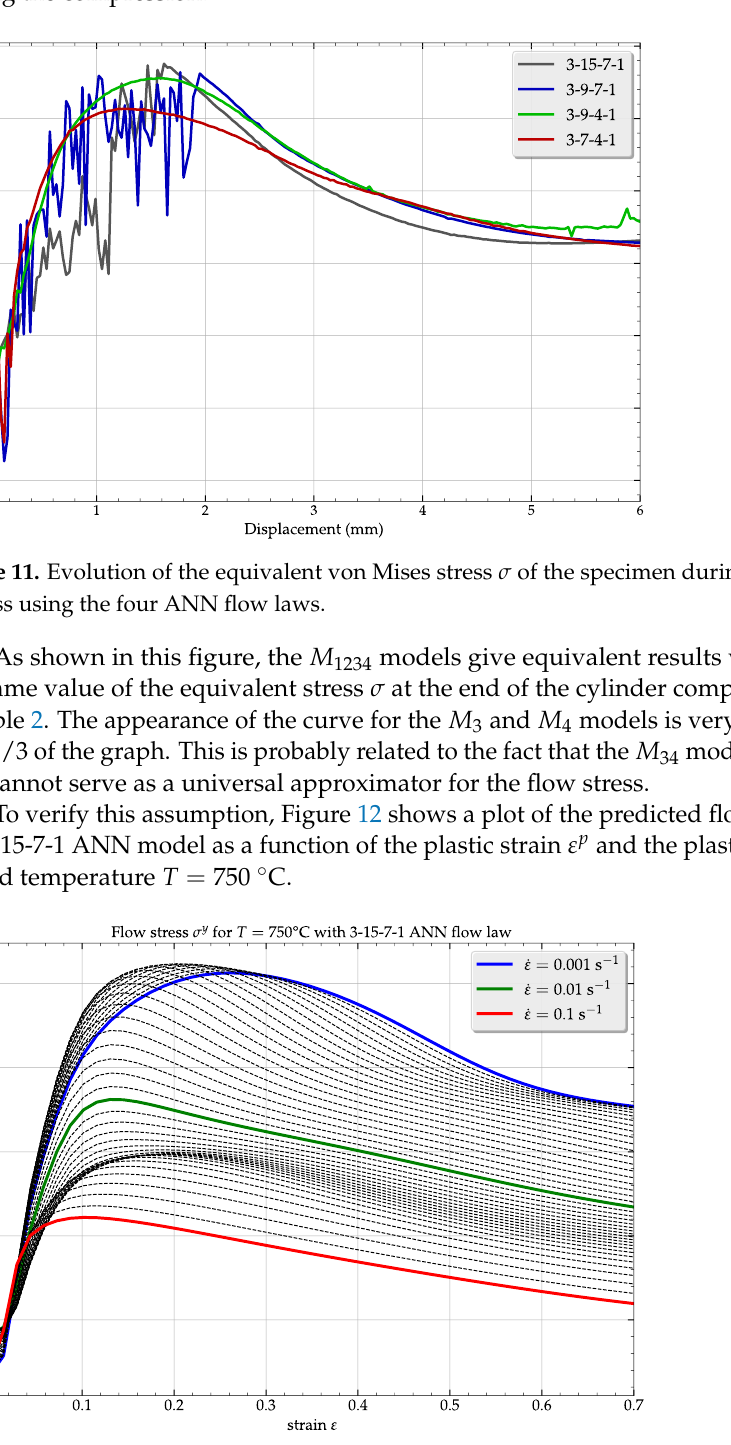
Figure 12. Predicted flow stress σ y as a function of ( ε p , the 3-15-7-1